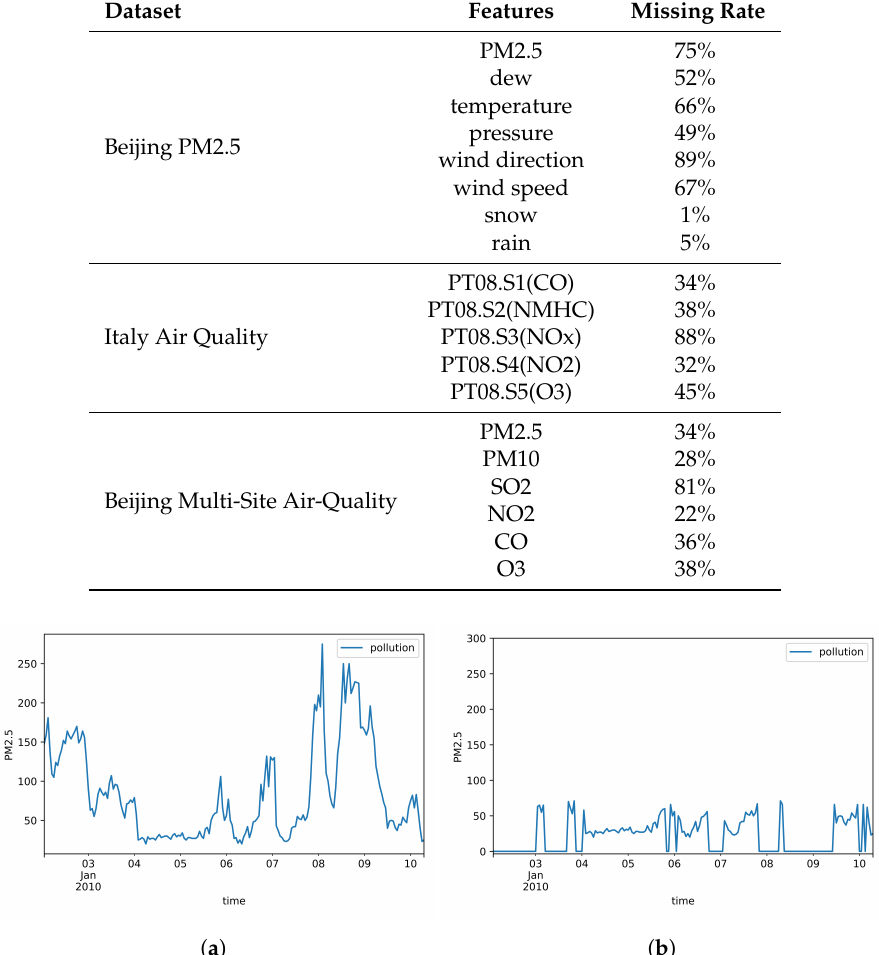
Figure 2. PM2.5 concentration over 200 samples in Beijin PM2.5. ( a ) Actual data; ( b ) Generated missing data.